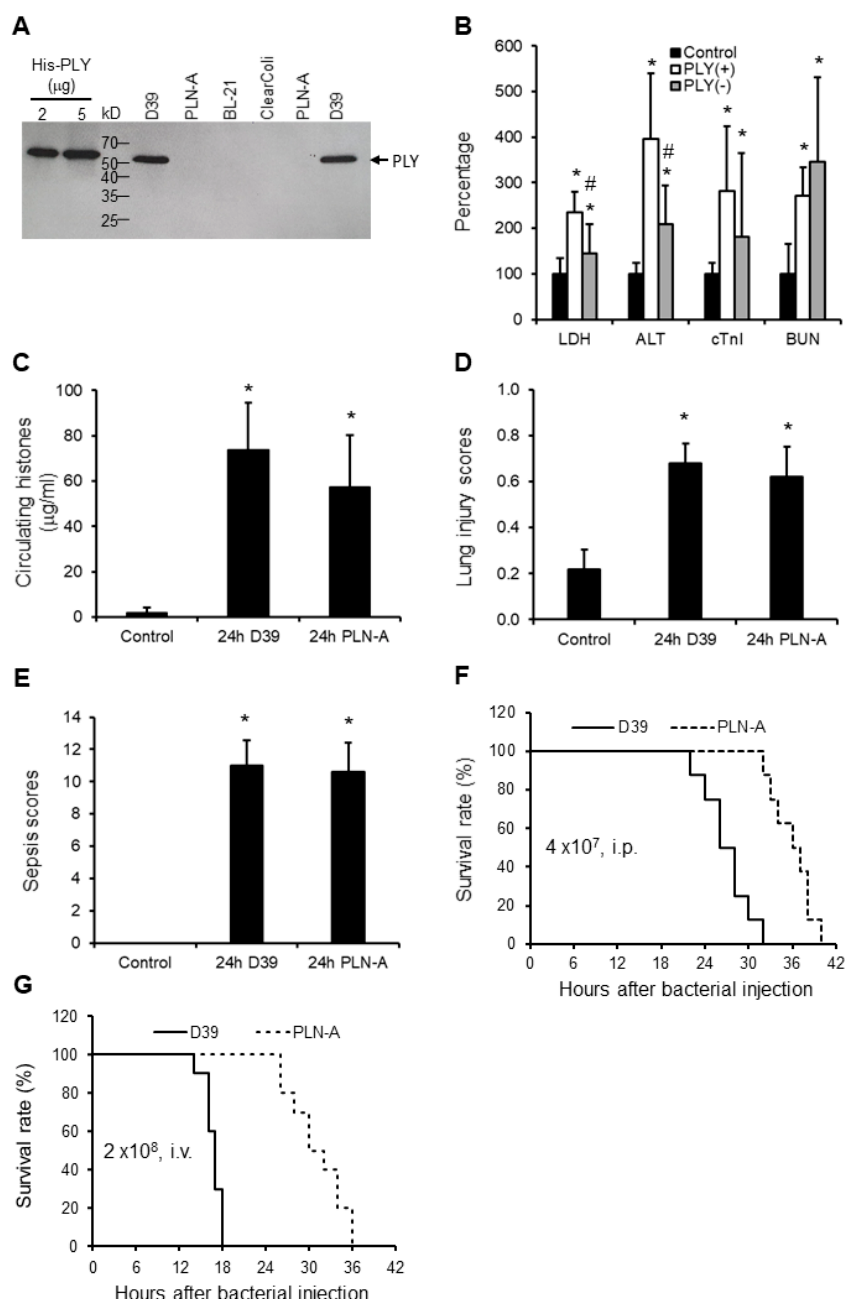
Figure 3. Mice sepsis models induced by peritoneal injection of D39 and PLN-A bacteria. ( A ) Western blot shows that D39 has detectable PLY, but PLN-A or E.Coli have no detectable PLY. ( B ) Five mice per group were injected with saline (control), D39 (PLY(+)) (4 × 10 7 CFU/mouse, i.p.), or PLN-A (PLY( − ) (4 × 10 7 CFU/mouse, i.p.). Blood and organs were collected at 24 h after injection. The means ± SD of relative increase in LDH, ALT, cTnI, and BUN are presented. An ANOVA test * p < 0.05 was compared to the control. # p < 0.05 was compared to the PLY(+) bacteria-induced mouse model. The means ± SD of circulating histones ( C ), lung injury scores ( D ), and sepsis scores ( E ) showed no statistical difference between PLY (+) and PLY ( − ) models, but * p < 0.05 was compared to control groups. ( F and G ) Survival curves of mice injected with D39 or PLN-A (4 × 10 7 CFU/mouse i.p. ( F ); or 2 × 10 8 CFU/mouse i.v. via the tail vein ( G )). 8–10 mice per group, log rank test, p <